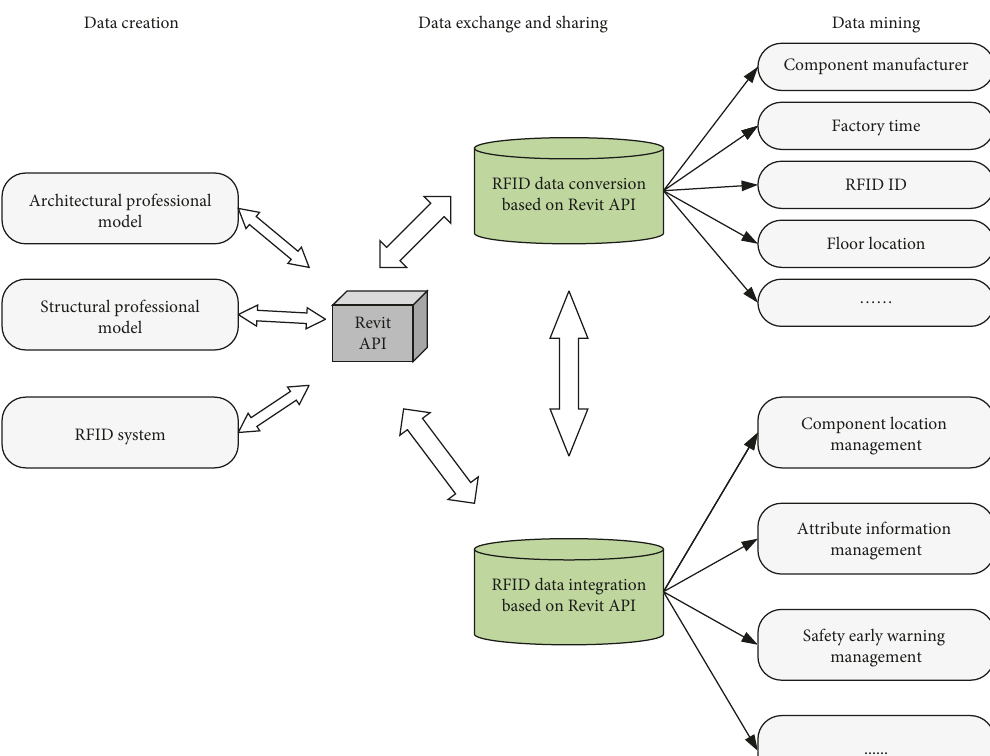
Figure 1: BIM and RFID data interface